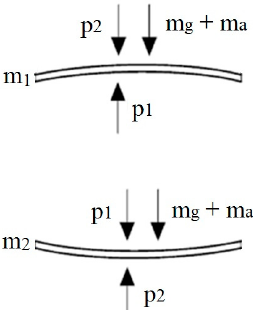
Figure 11. Acceleration-free transducer geometry [4].